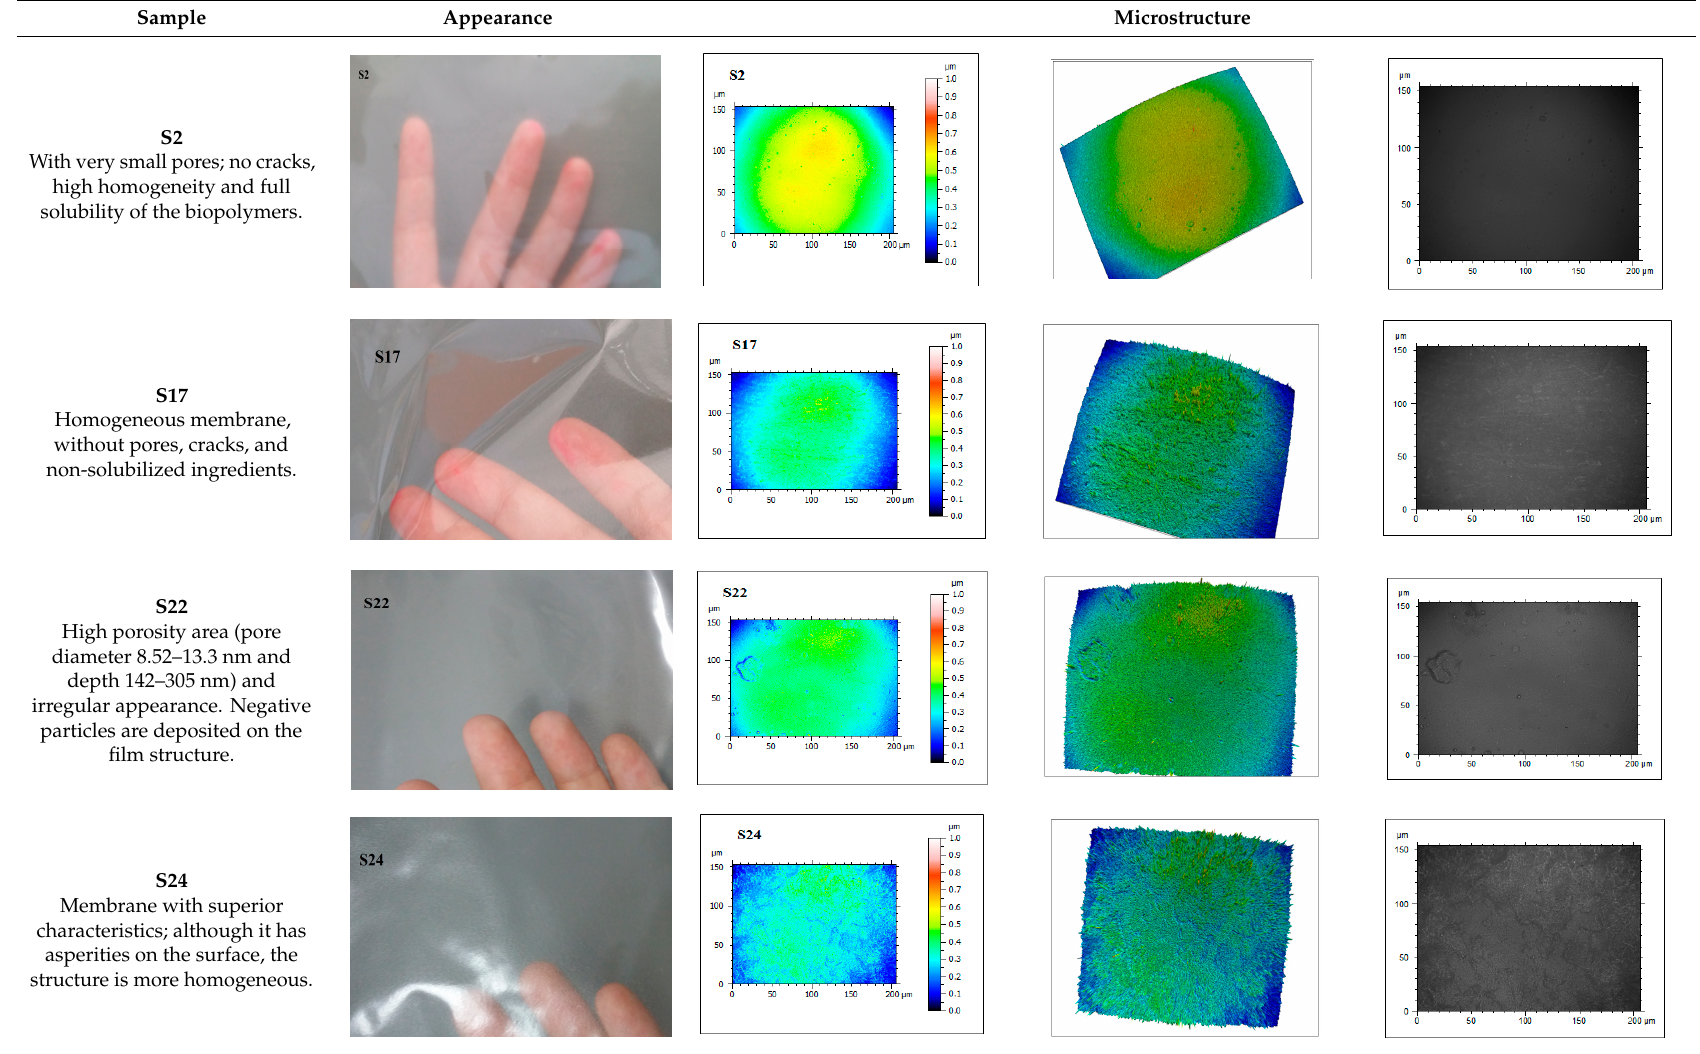
Table 3. Images and microstructures of materials suitable for use as food packaging.